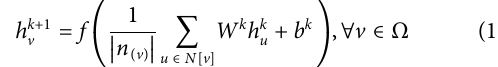
Frontiers in Energy Research |